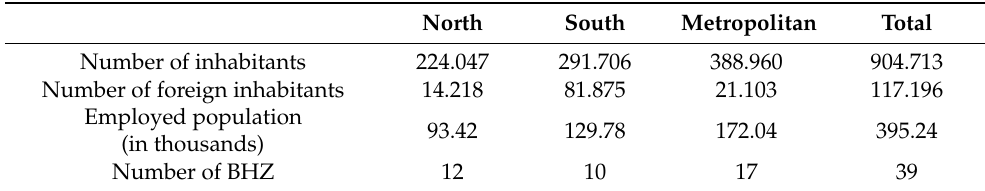
Table 1. Inhabitants according to the area of the island, taking into account foreign population (ISTAC 2018), employed population (ISTAC 2020) and BHZ (https://www3.gobiernodecanarias.org/ sanidad/scs/mapa) (accessed on 26 May 2020).